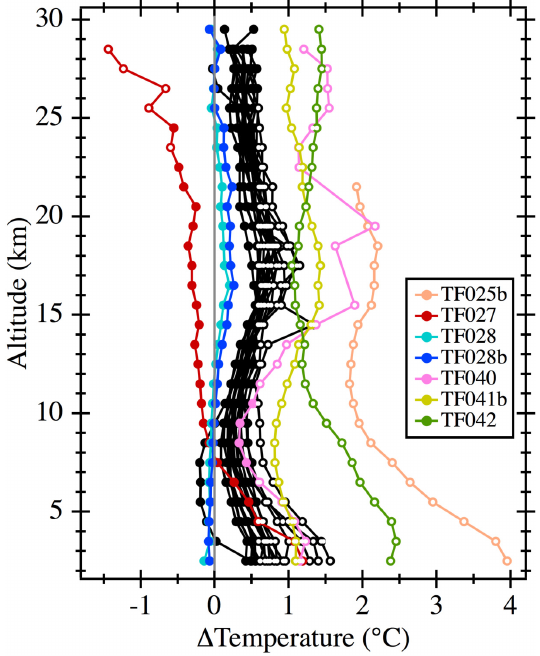
Fig. 2. Same as Fig. 1 except the RS92-iMet T differences are presented as median differences in 1-km altitude bins ( 1T ). Open circles depict the 38% of 1T that exceed the 2 σ combined mea- surement uncertainty of ± 0.58 ◦ C. Of all the excessive 1T , 51% are located above